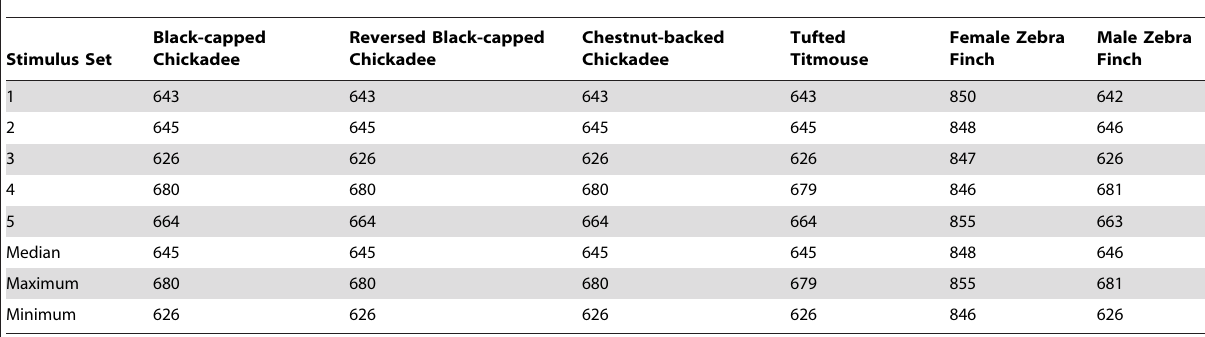
Table 1. Duration (ms) of ‘ dee ’-like Notes per Iteration for Each Stimulus